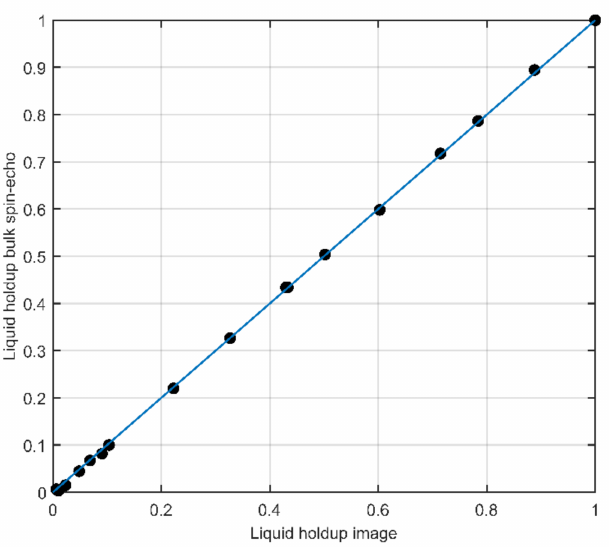
Figure 13. The liquid holdup as determined from a bulk spin-echo experiment as a function of the liquid holdup as determined from the 1D liquid distribution images obtained using a broad band constant-gradient LFA-CPMG pulse sequence. The measurements for 19 different liquid holdups show a 1-to-1 correspondence between the two